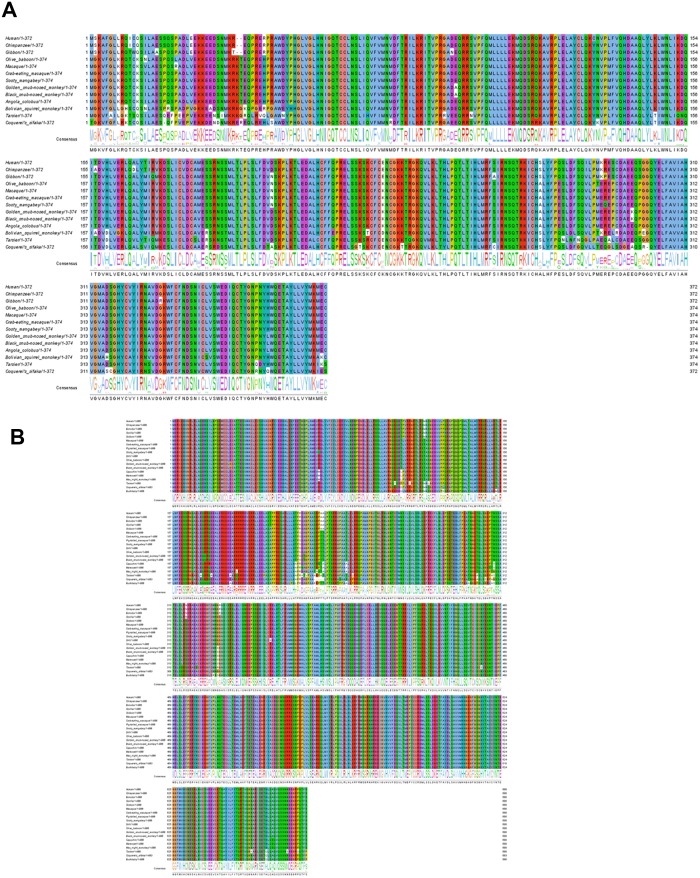
The conservativeness analysis of DUBs among anthropoids.Primate protein sequences were retrieved from the Ensemble database (http://www.ensembl.org). Orthologues of USP18 (A) and USP49 (B) in other species were confirmed with the comparative genomics from the Ensemble and UCSC Genome databases. Multiple protein sequences alignment was created using the MUSCLE algorithm. Further visualization and conservation analysis with the consensus sequence logos of the multiple sequence alignment were conducted using the Jalview program. The amino acids were colored according to their chemicophysical properties, and the length was shown in the sequence name. Dashes ('-') represent gaps in the sequence.